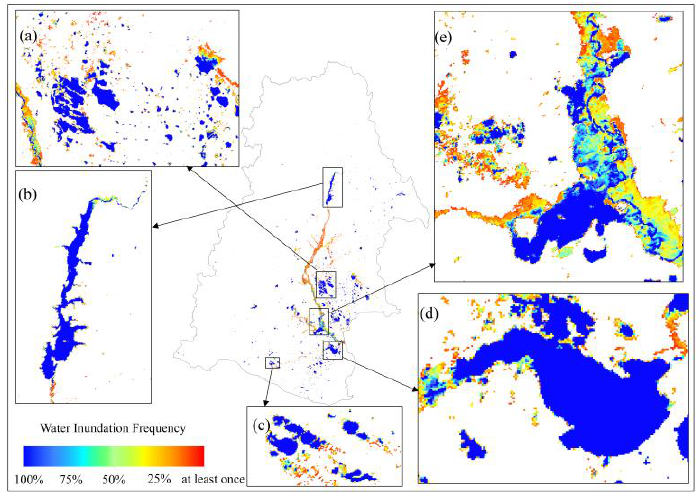
Figure 11. Nenjiang Basin 2000 – 2018 inundation frequency and its spatial distribution map. ( a ) Zhalong wetland, ( b ) Nierji reservoir, ( c ) Xianghai wetland, ( d ) Chagan Lake, and ( e ) Momoge wetland.